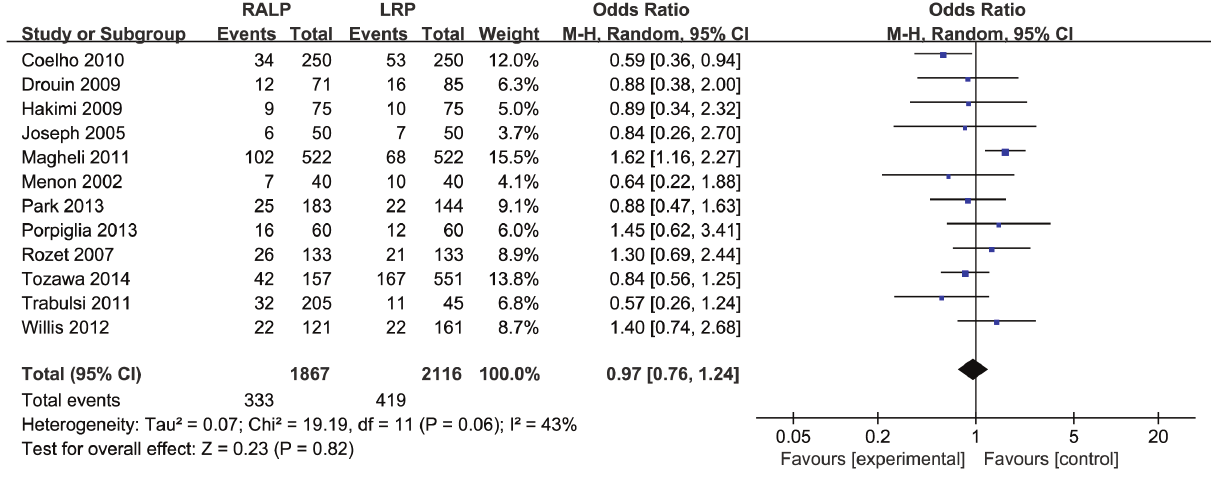
Figure 5: The forest plot for the rate of positive surgical margins of RALP and